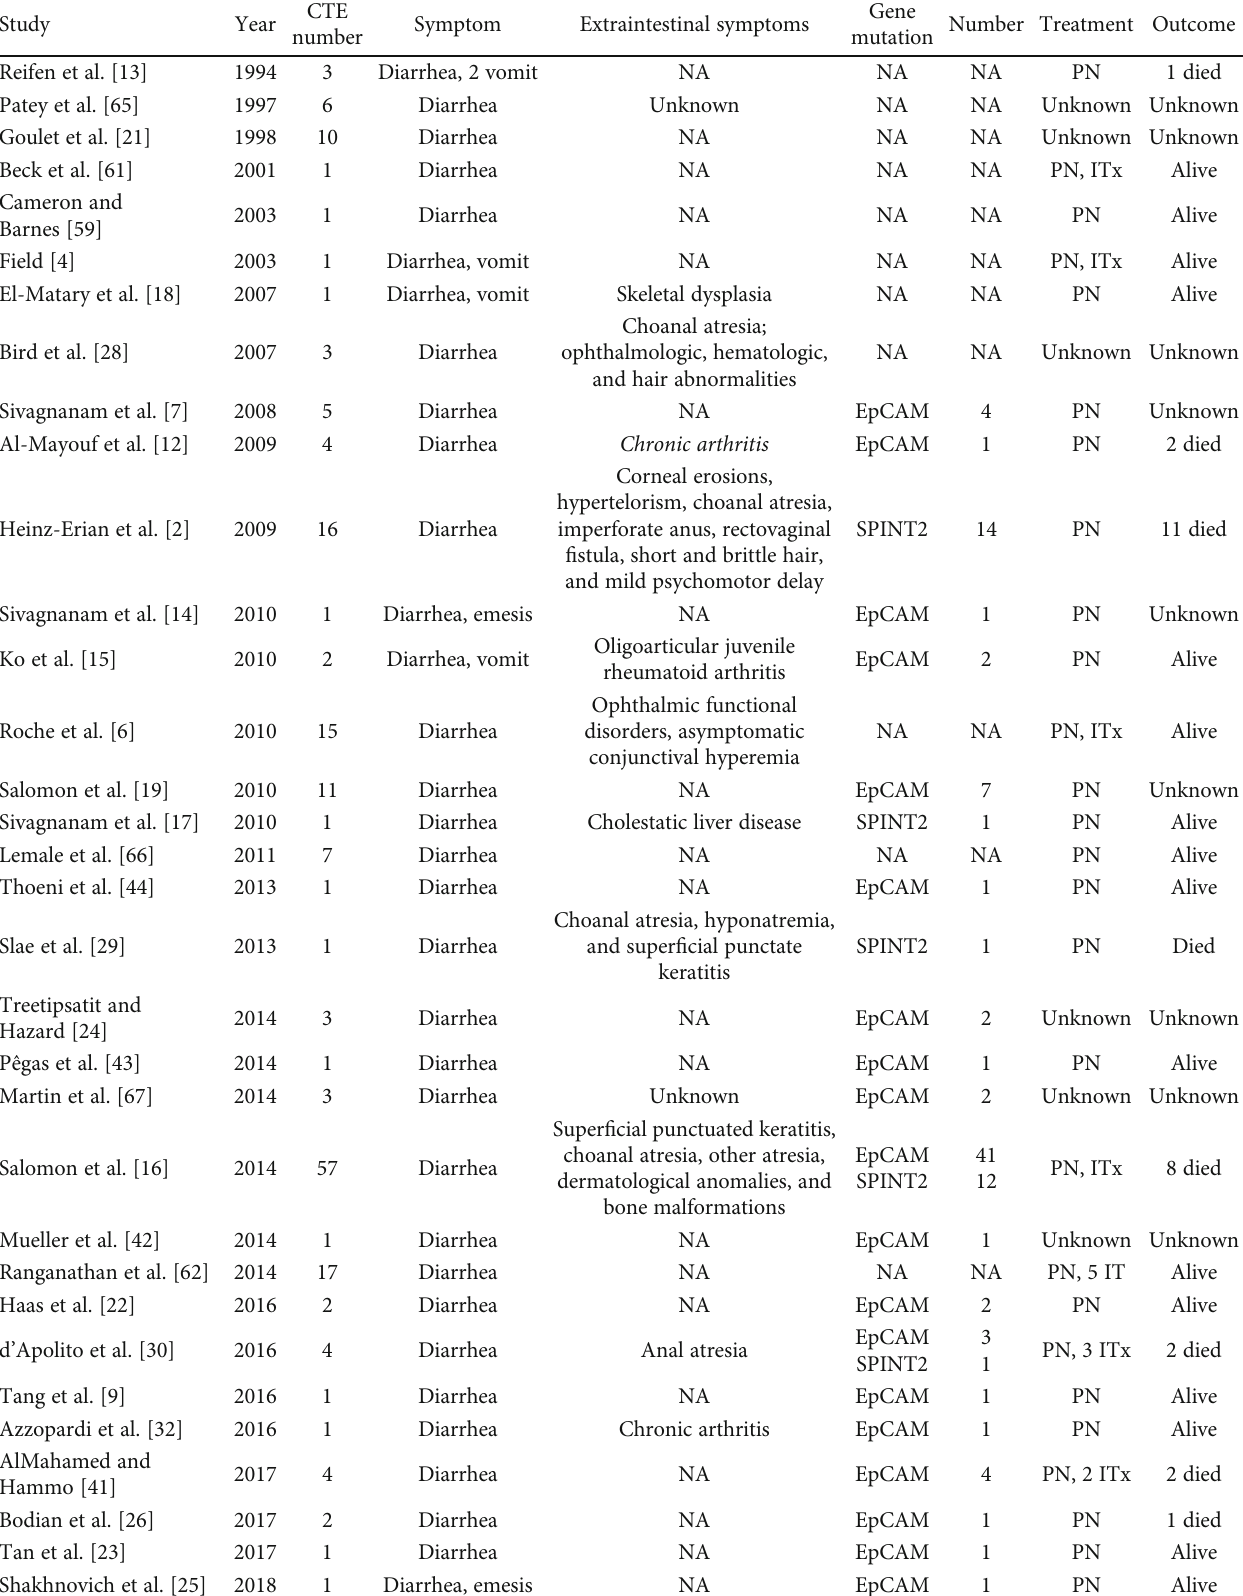
Table 1: Clinical features, gene mutations, and treatments of CTE in reported